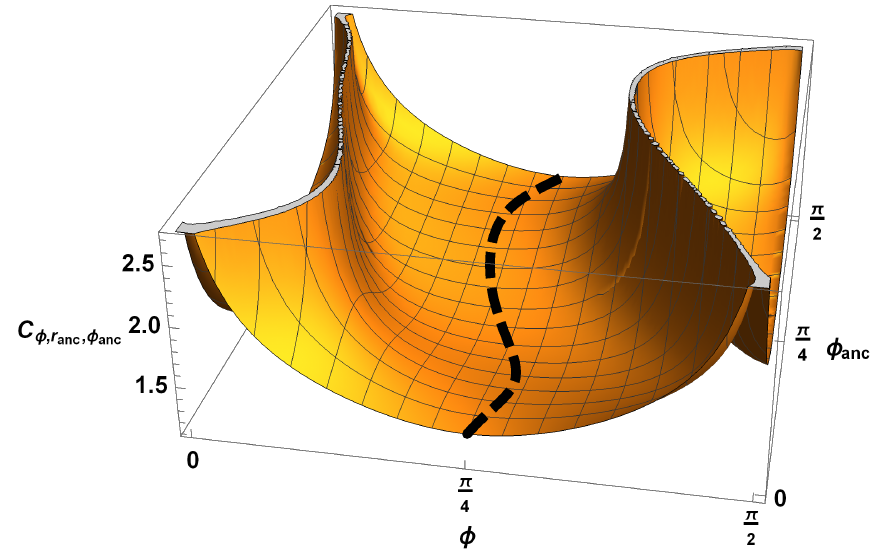
Figure 3. The purification complexity (2.42) as a function of the squeezing angles ( φ, φ anc ) for βω = − 2 ln tanh 50 and ancillary squeezing r anc = 1 . The thick dashed line corresponds to the minimum as a function of ( φ, φ anc ) , tracing out a one-parameter curve in the valley of the complexity. In general, the minimized complexity of (2.42) over the free purification parameters ( φ, r anc , φ anc ) is also a one-parameter curve, and approaches C th ≈ π